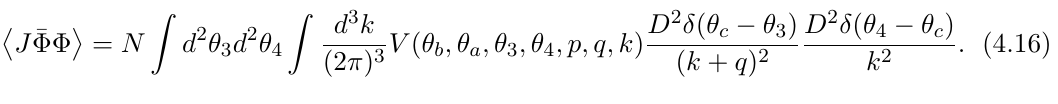
Figure 7. Interacting contribution to